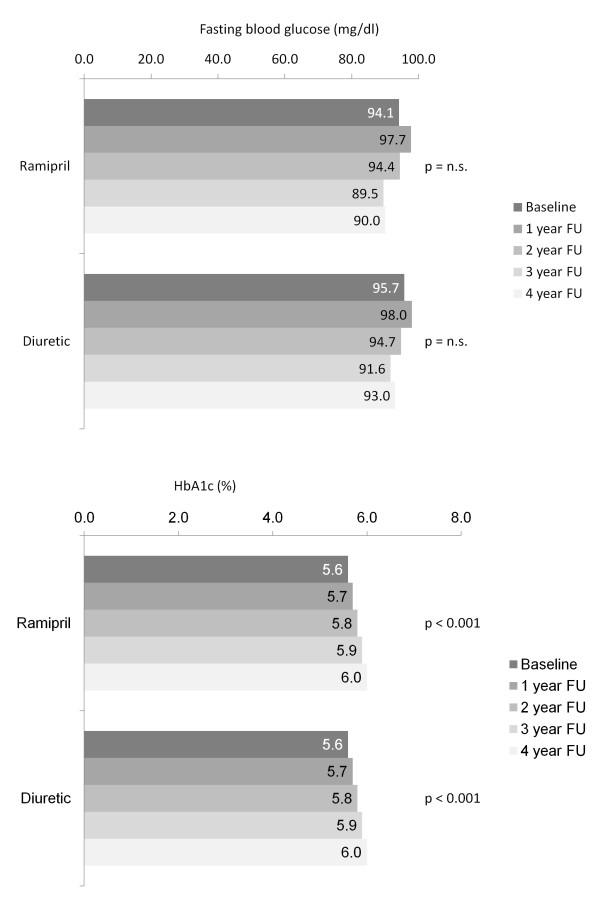
Changes in fasting blood glucose and HbA1c trough years 1 to 4. Legend: FU, follow-up.